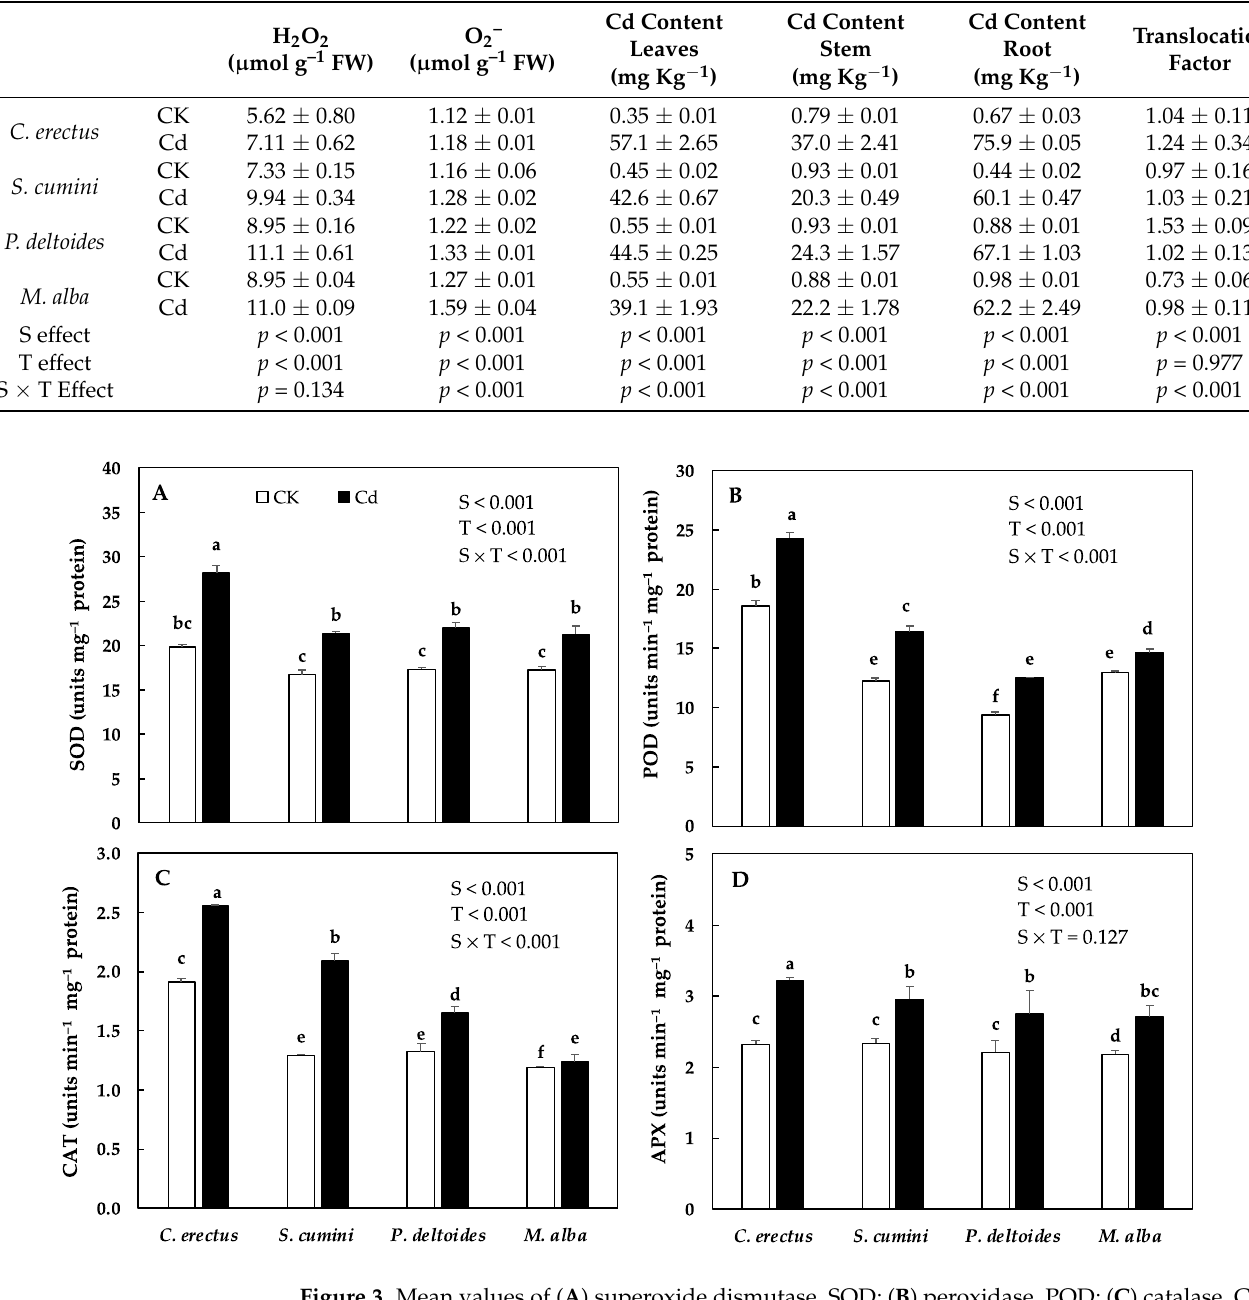
Figure 3. Mean values of ( A ) superoxide dismutase, SOD; ( B ) peroxidase, POD; ( C ) catalase, CAT; and ( D ) ascorbate peroxidase, APX under CK and Cd treatments. Small letters depict significant differences between treatment means (n = 5).